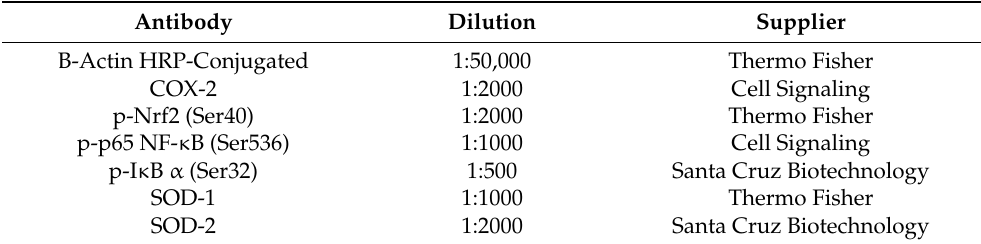
Table 1. Primary antibodies used in the